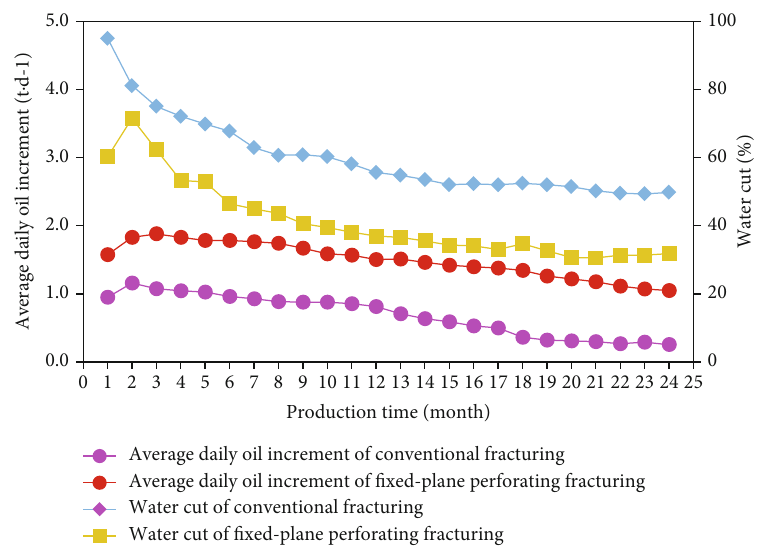
Figure 7: Production curve of fi xed-plane perforation fracturing compared with conventional